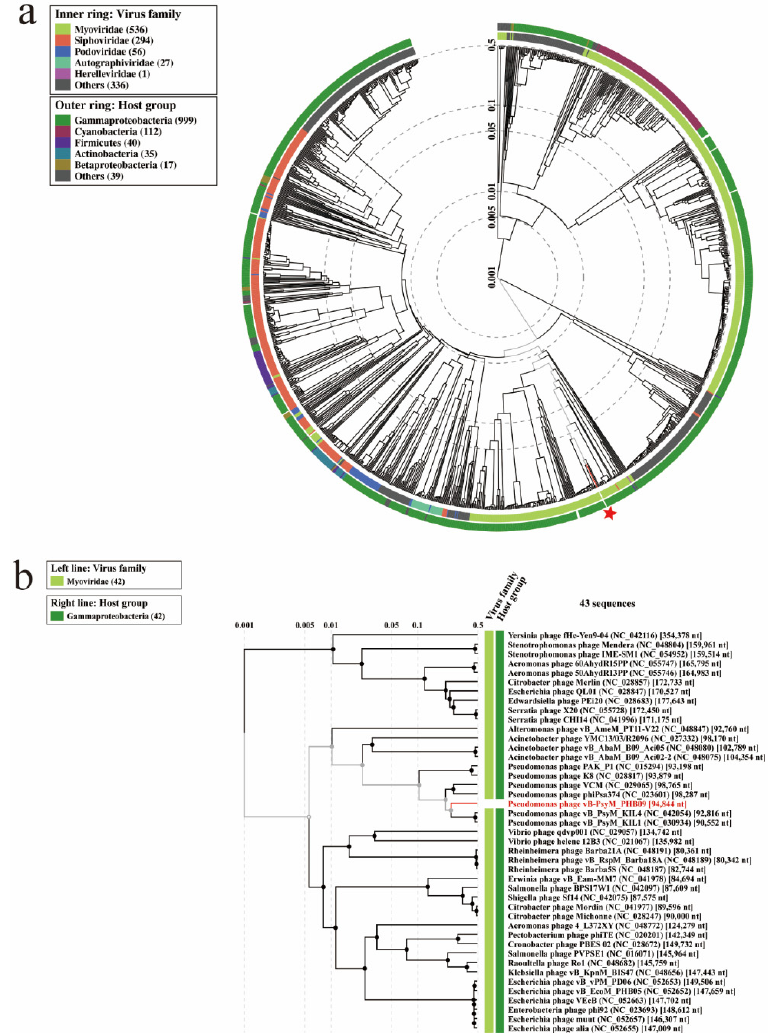
Figure 6. Proteomic relationships between PHB09 and other phages. ( a ) The dendrogram represents proteome of PHB09 with 4240 prokaryotic dsDNA virus genomes in wide similarity relationships. The red-colored star mark indicates phage PHB09. ( b ) A proteomic tree base on tBLASTx genomic sequence comparisons of 43 bacteriophage genomes.